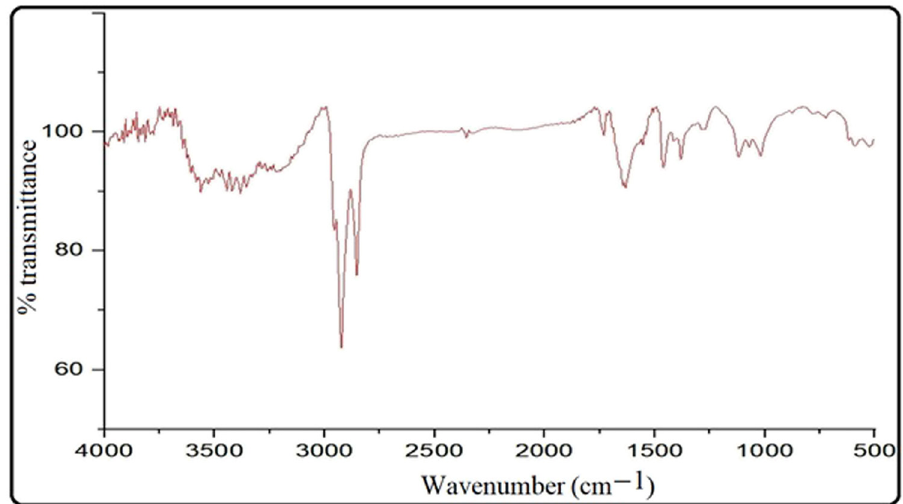
Figure 2: FTIR of biogenic CuO NPs.